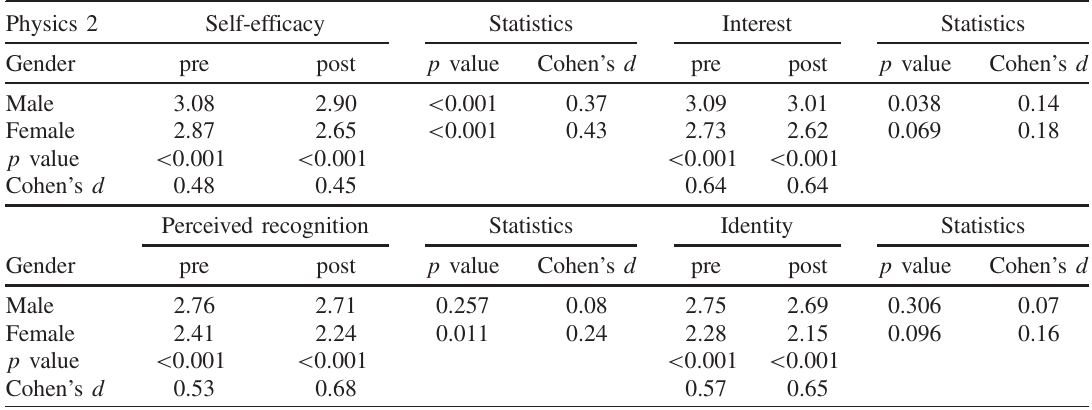
TABLE X. Descriptive statistics of female and male students ’ motivational beliefs in physics 2 in both years studied. The sample size is 626 (411 male students and 215 female students).